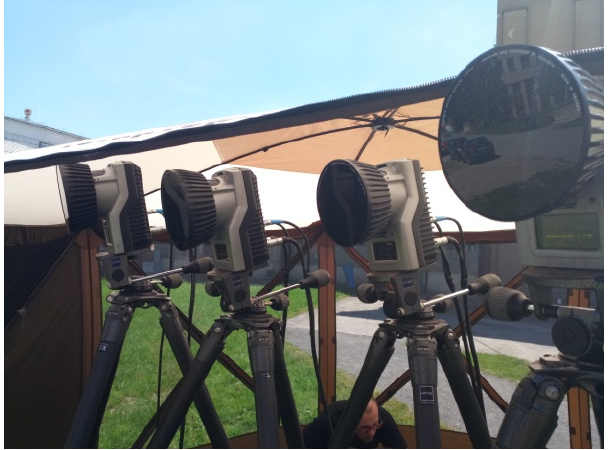
Figure 5. Device for measuring the exact speed of the vehicle—System Qualisys.